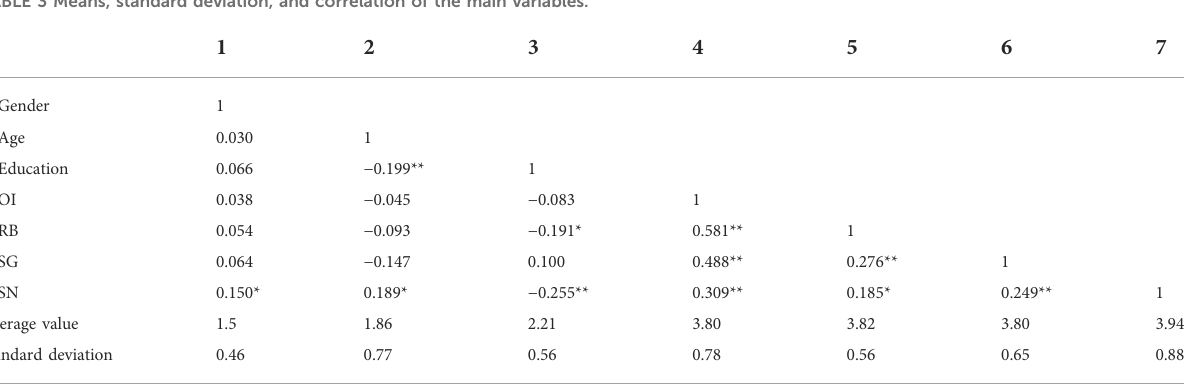
TABLE 3 Means, standard deviation, and correlation of the main variables.